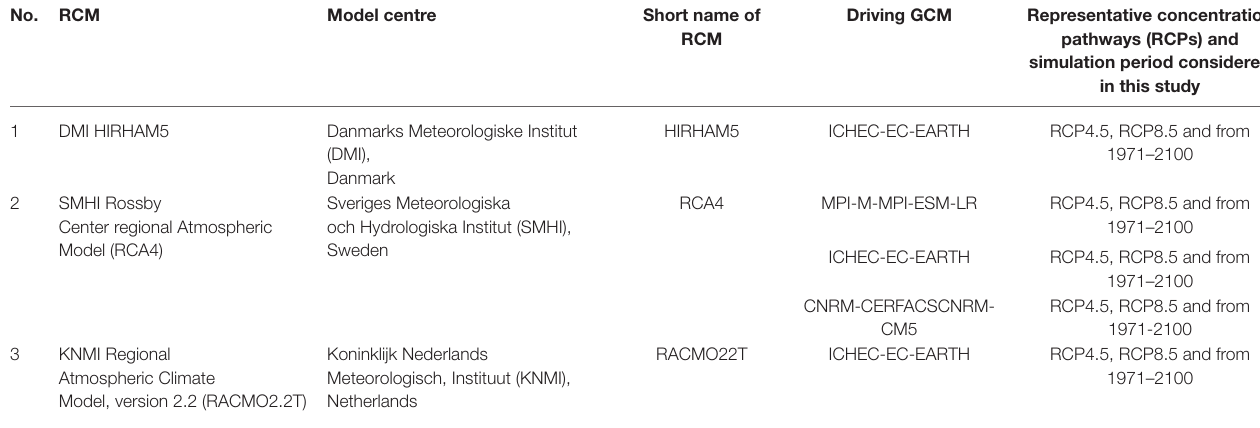
TABLE 1 | Details of CORDEX-RCMs and the driving